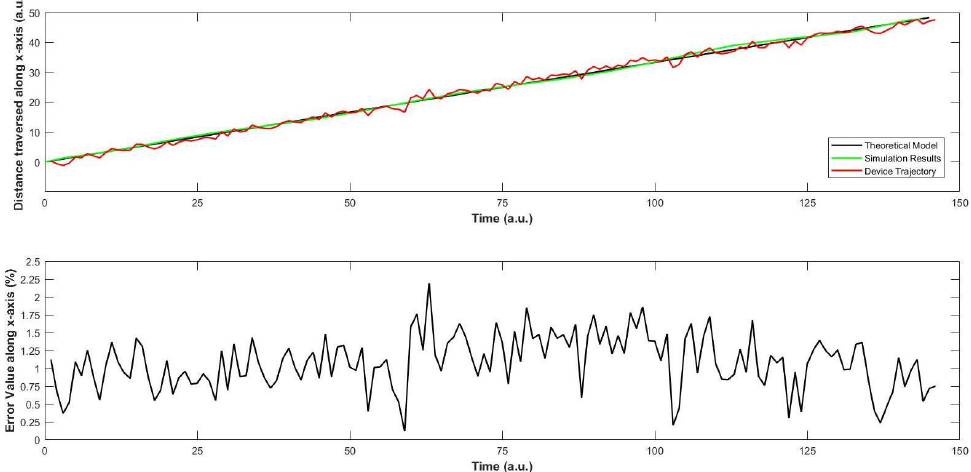
Figure 12. Second trajectory scenario: Investigation of change in values of x. ( top ) shows a comparison between the ideal, simulation and actual (trajectory) values during the movement of the quad-copter along the x-axis, and ( bottom ) shows the average error between the simulated results and the actual (trajectory) values, which is very small.